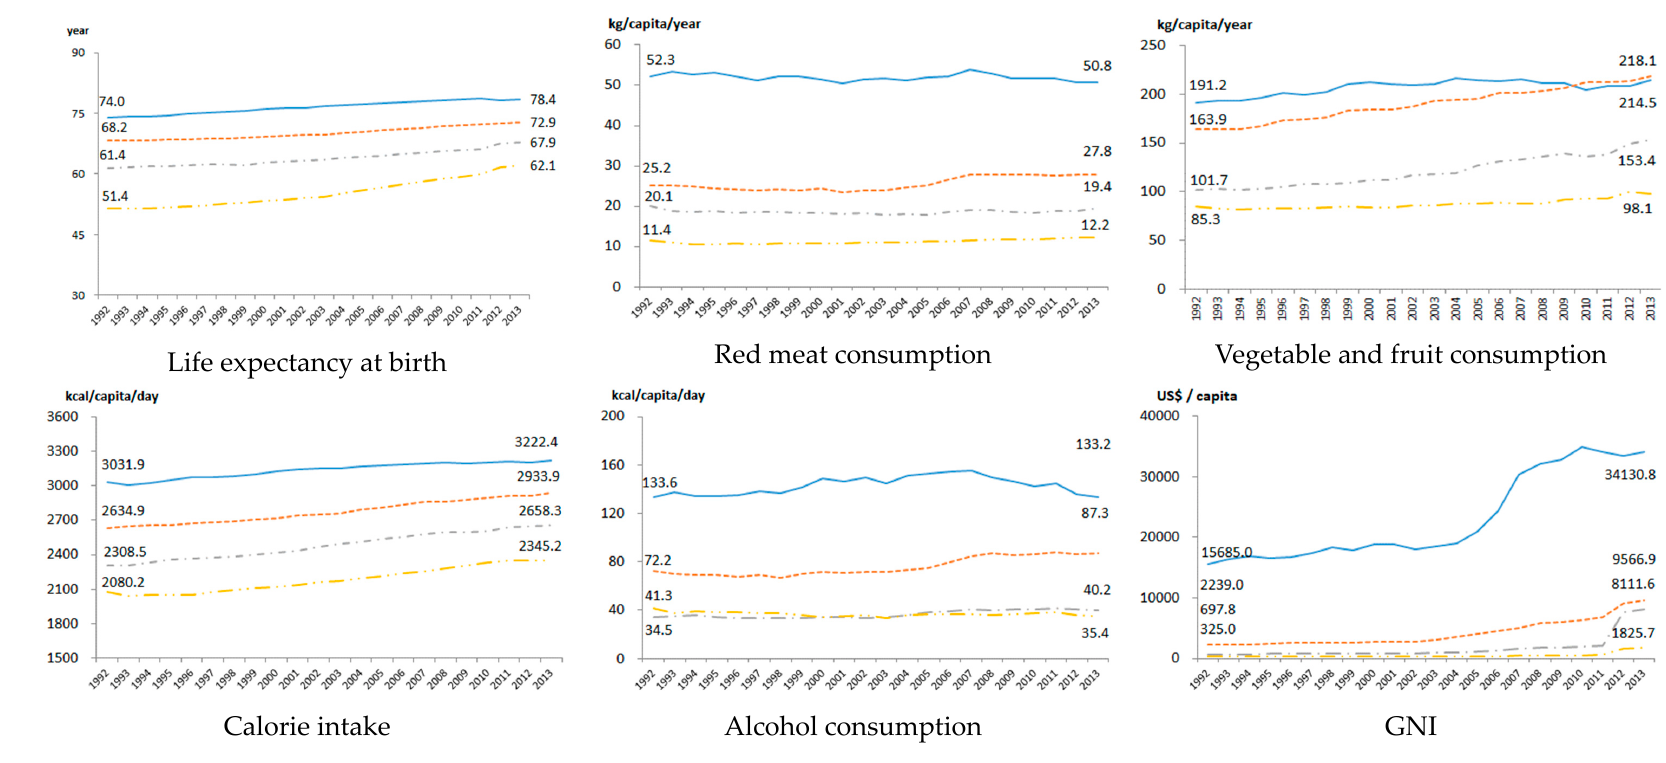
Figure 5. Trends of indices used to track health by the World Bank by income level over the period 1992–2013. LIC: Low-income countries; LMIC: Lower-middle-income countries; UMIC: Upper-middle-income countries; HIC: High-income countries; GNI: Gross Nation Income.